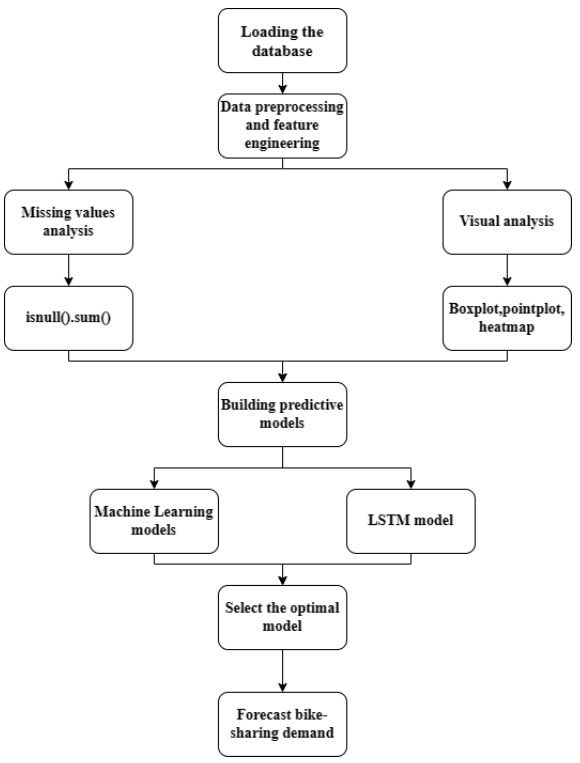
Figure 2. Flowchart of the